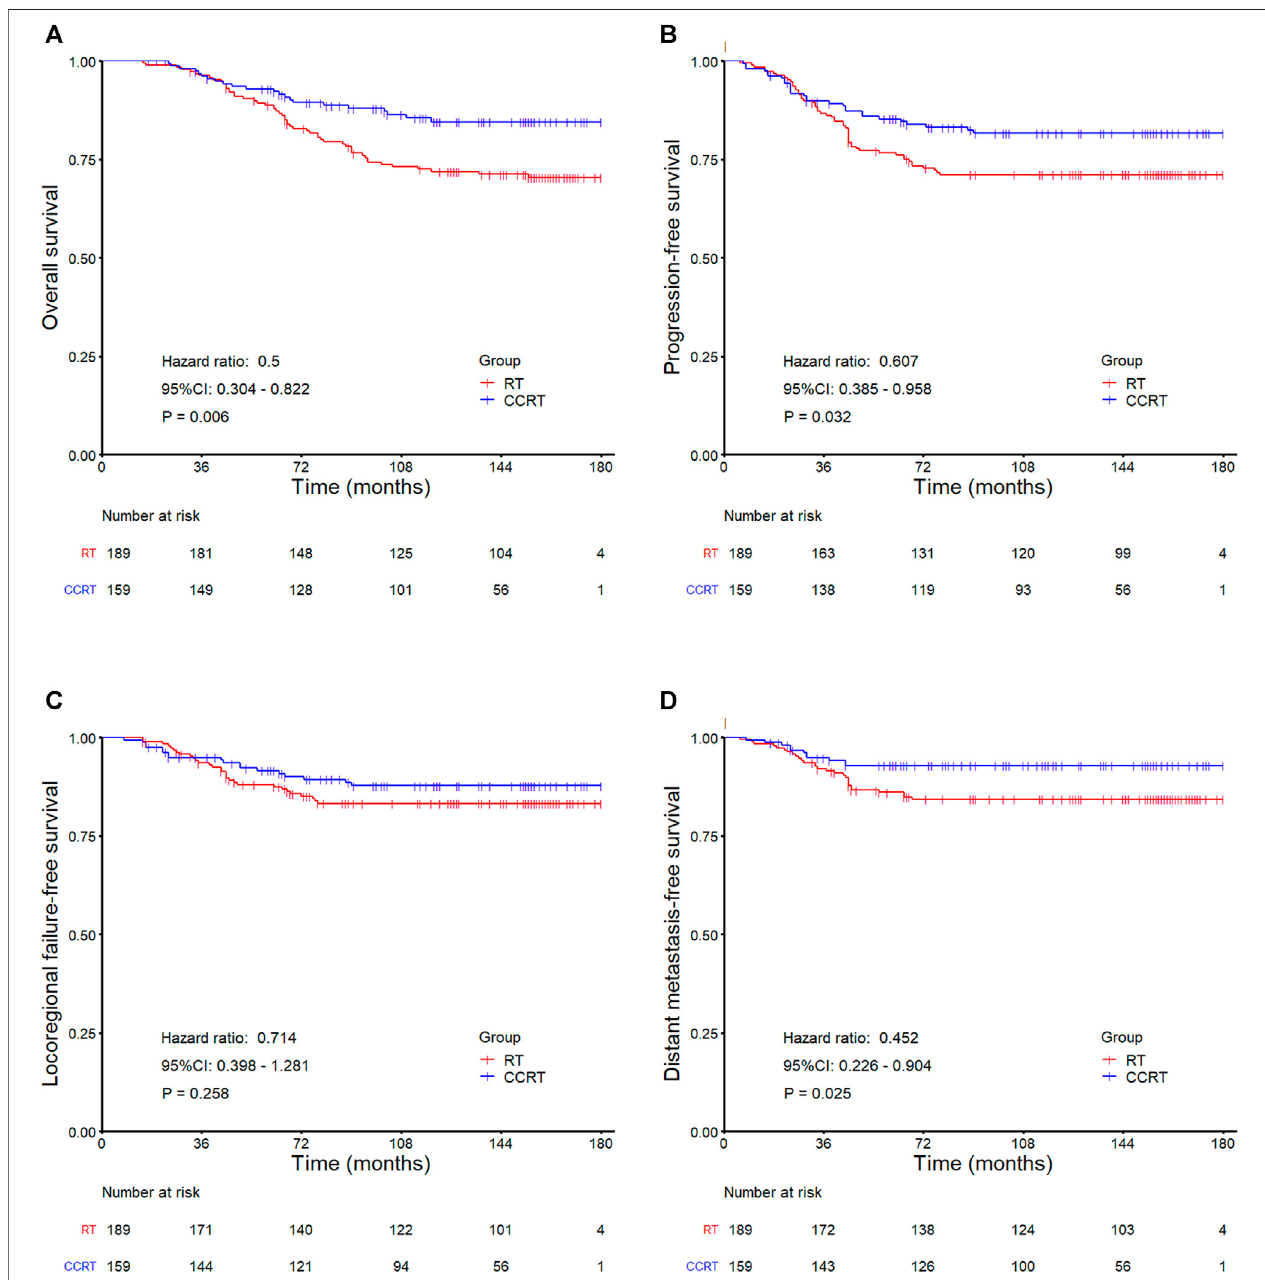
FIGURE 3 | Kaplan-Meier survival curves for the RT and CCRT groups in the 2DRT subgroup: (A) Overall survival, (B) Progression-free survival, (C) Locoregional failure-free survival, (D) Distant metastasis-free survival. Abbreviation: RT (cid:1) radiotherapy, CCRT (cid:1) concurrent chemoradiotherapy, 2DRT (cid:1) two-dimensional